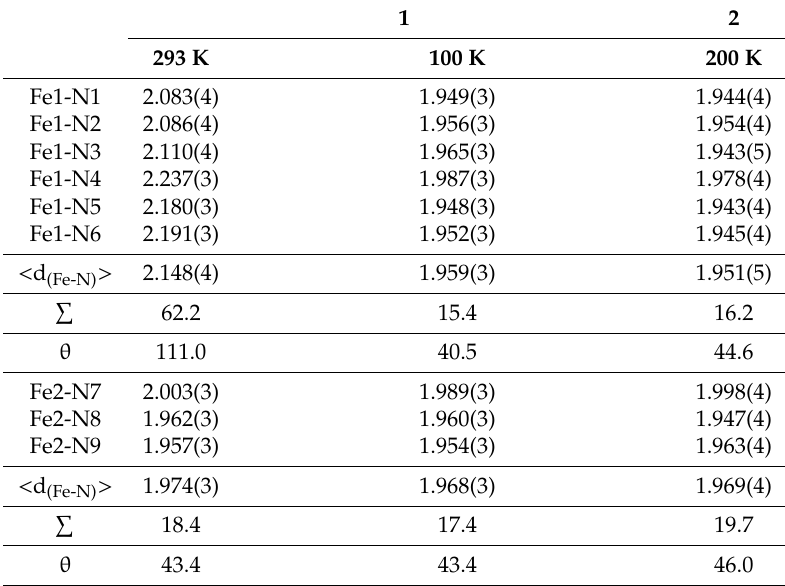
Table 2. Fe-N bond lengths (Å) and